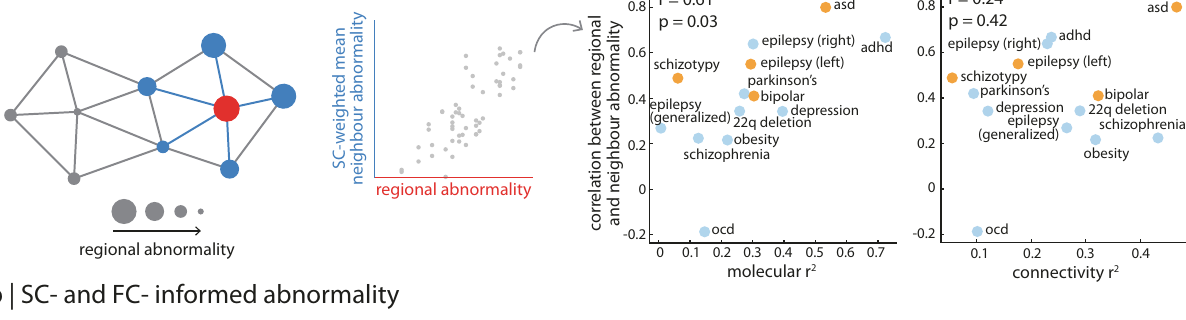
correlationbetweenregionabnormalityandSC-andFC-weighted meanneighbour abnormalityissigni fi cant( p spin <0.05). c Left:aregionwithhighabnormalitythatis also connected to regions with high abnormality is considered a likely disorder epicentre. Middle: epicentre likelihood was calculated as the mean rank of region and neighbour abnormality (see Supplementary Fig. 7 for individual epicentre likelihoods). Right: median epicentre likelihood was calculated for the disorders thatshowasigni fi cantcorrelationbetweenregionalandneighbourabnormality.To limit biasing cross-disorder epicentre likelihood towards epilepsy epicentre like- lihood,leftandrighttemporallobeepilepsyepicentrelikelihoodwasmergedintoa single mean epicentre likelihood map, prior to calculating the median. For com- pleteness, Supplementary Fig. 8 shows cross-disorder epicentre likelihood when calculated using alternative